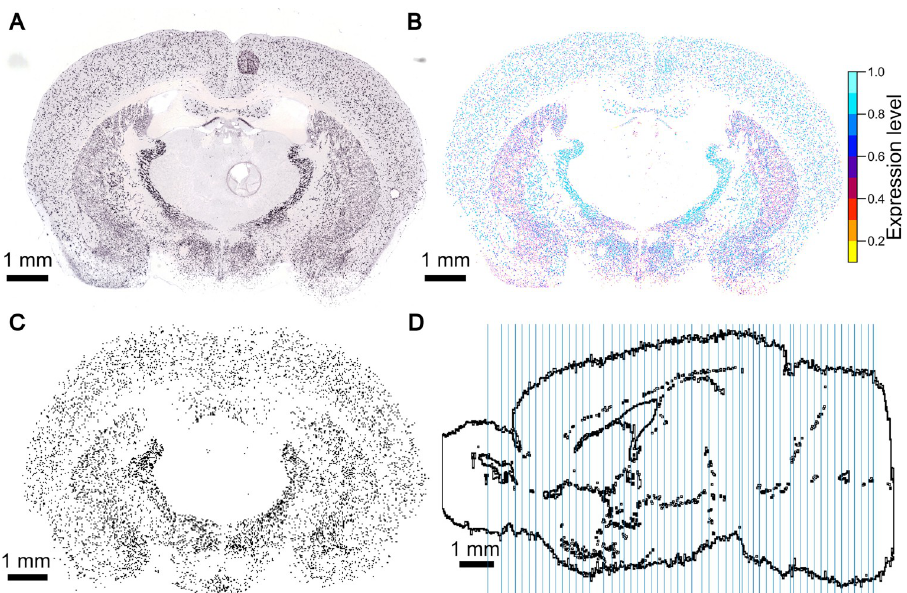
Fig 3. AIBS GAD67 ISH experiment data. (A) raw image, (B) filtered image and (C) realigned binarized image. This AIBS ISH experiment highlights inhibitory cells of the mouse brain (experiment No 79556706—slice 22). The raw slice image (A) contains artifacts and a minimum expression value offsets the dataset. The filtered image (B) is derived from the raw image (A) by the AIBS. Somas reacting to GAD67 are detected in the raw image and isolated from the background. The different colors of the cells in (B) represent the different levels of expression (AIBS 2015 white paper). (A) and (B) have been downloaded on the AIBS website [68] with permission of the AIBS. The filtered images are realigned and thresholded to obtain the binarized image shown in (C). (D) Positions of the manually realigned coronal stained slices, shown in blue on a sagittal slice of the CCFbbp brain volume.